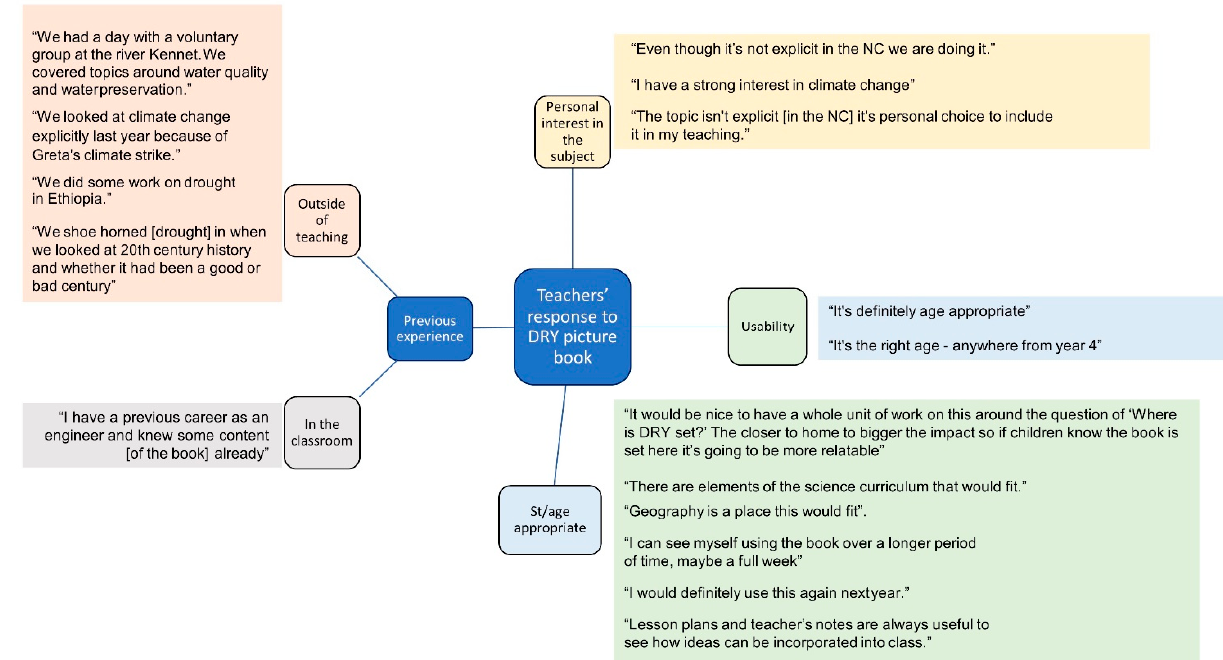
Figure 4. Practicing teacher responses to the DRY picture book.